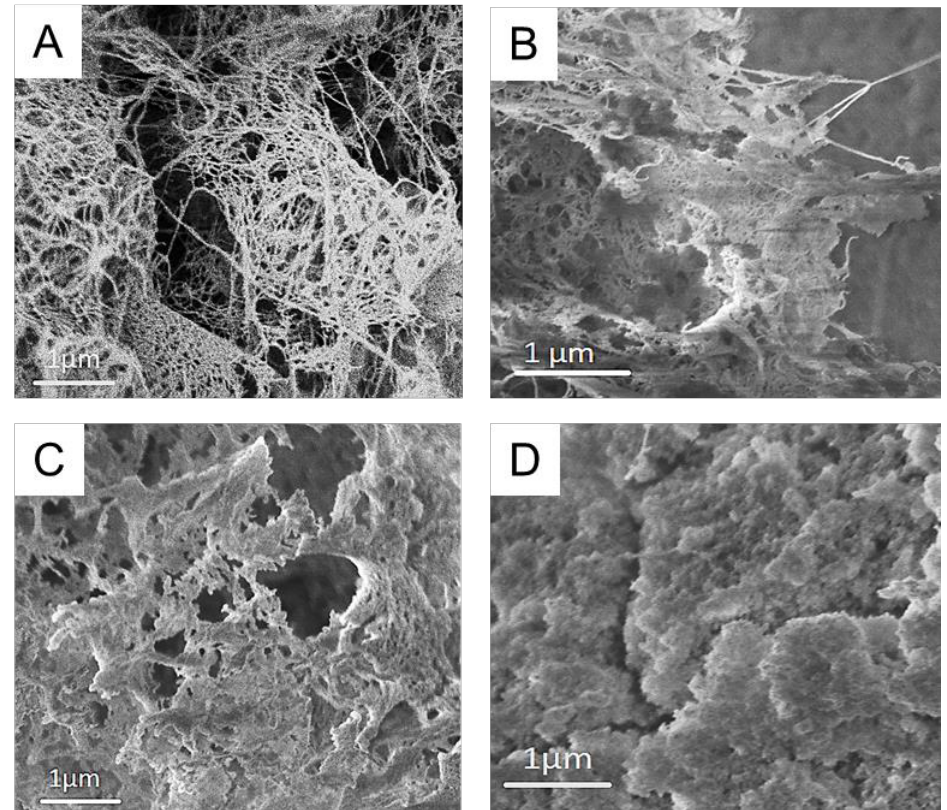
Figure 3. Scanning electron micrographs of CNF ( A ), CNF – Silica ( B ), CNF – Methylcellulose – Silica ( C ), and CNF – Starch – Silica ( D ) cryogels.